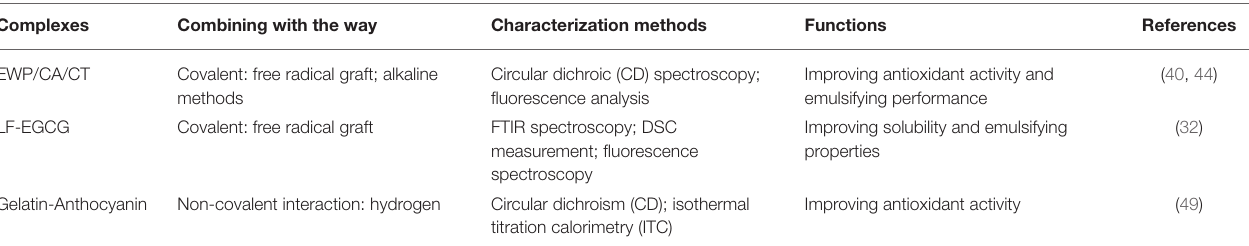
TABLE 1 | Typical animal protein-polyphenol complexes.